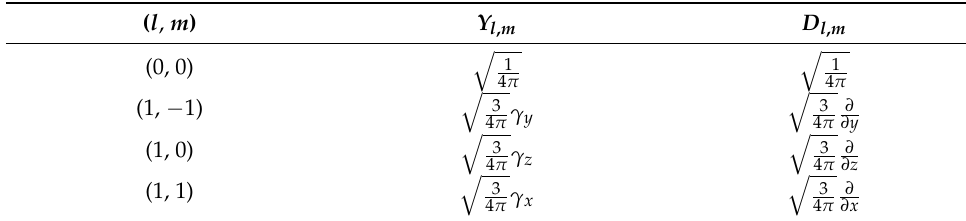
Table 1. Correspondence between Y l , m and D l , m up to the first